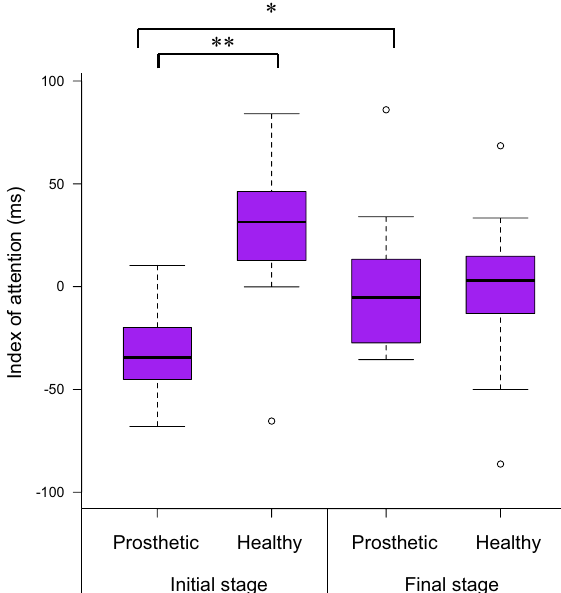
Figure 2. Change in index of attention to the prosthetic foot and healthy foot. The box plot shows the attention data for each foot and phase. In the initial stage, the index of attention to the prosthetic foot was lower than that to the healthy foot, while in the final stage, there was no significant difference between the index of attention to the prosthetic foot and that to the healthy foot. The index of attention to the prosthetic foot in the final stage was higher than that in the initial stage. There was no significant difference in the index of attention to the healthy foot between the initial and final stages. The circle indicates an outlier. * p < 0.05, ** p < 0.01.